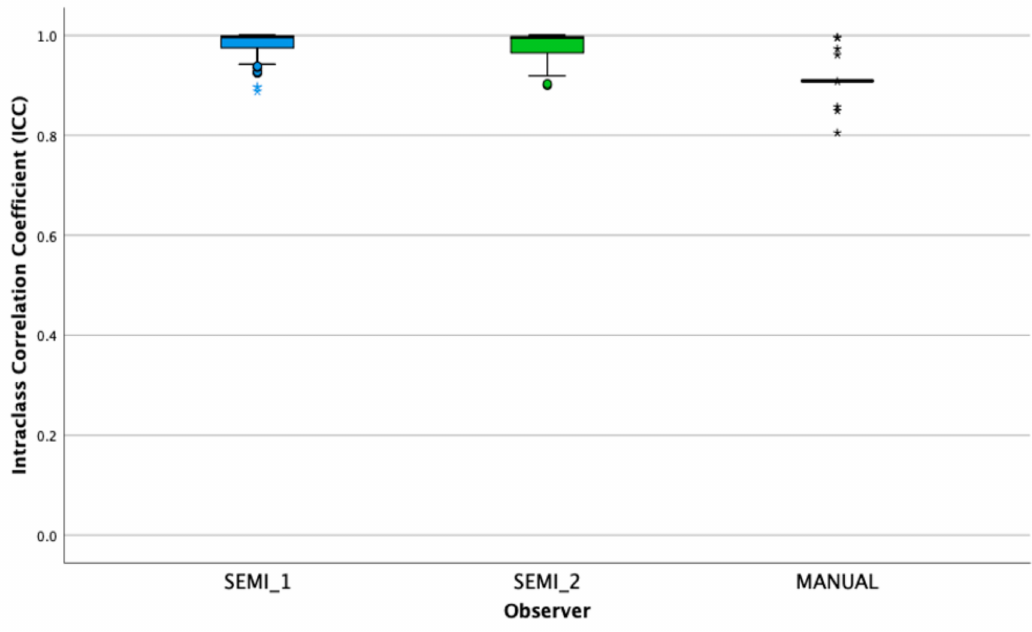
Figure 4. Boxplot of the ICC value represents by inter-observers’ reproducibility on the radiomic features. Table 6. ICC of radiomic